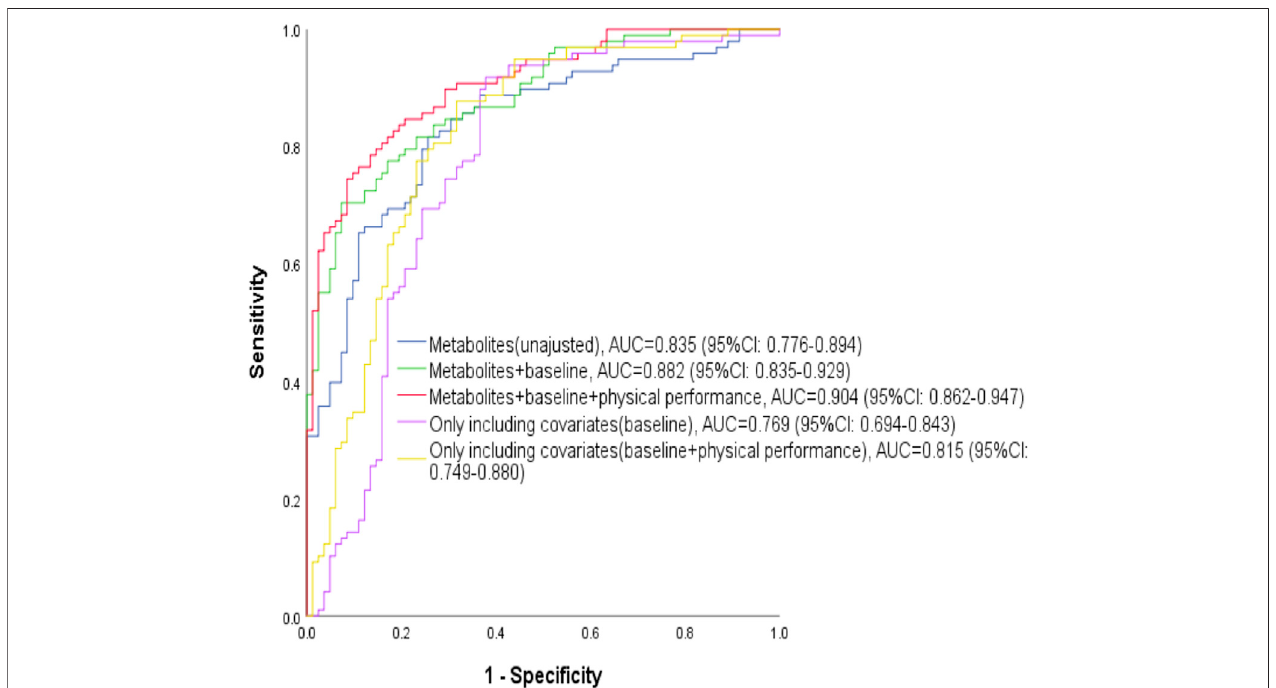
FIGURE3| ROCanalyses foridenti fi cationorpredictionofathleticstatus.ThebluecurverepresentstheROCcurveofwithfourmetabolitesofHDL,Gln,methanol and α -Glc; the green curve represents the ROC curve including the four metabolites and covariates (age and years of professional training at baseline); the red curve representstheROCcurveincludingthefourmetabolites,baselinecovariates(ageandyearsofprofessionaltraining)andphysicalperformanceindicators(abdominalcurl and sit-and-reach); the purple curve represents the ROC curve only including baseline covariates (age and years of professional training) without metabolites; the yellow curve represents the ROC curve only including baseline covariates (age and years of professional training) and physical performance indicators (abdominal curl and sit-and-reach) without